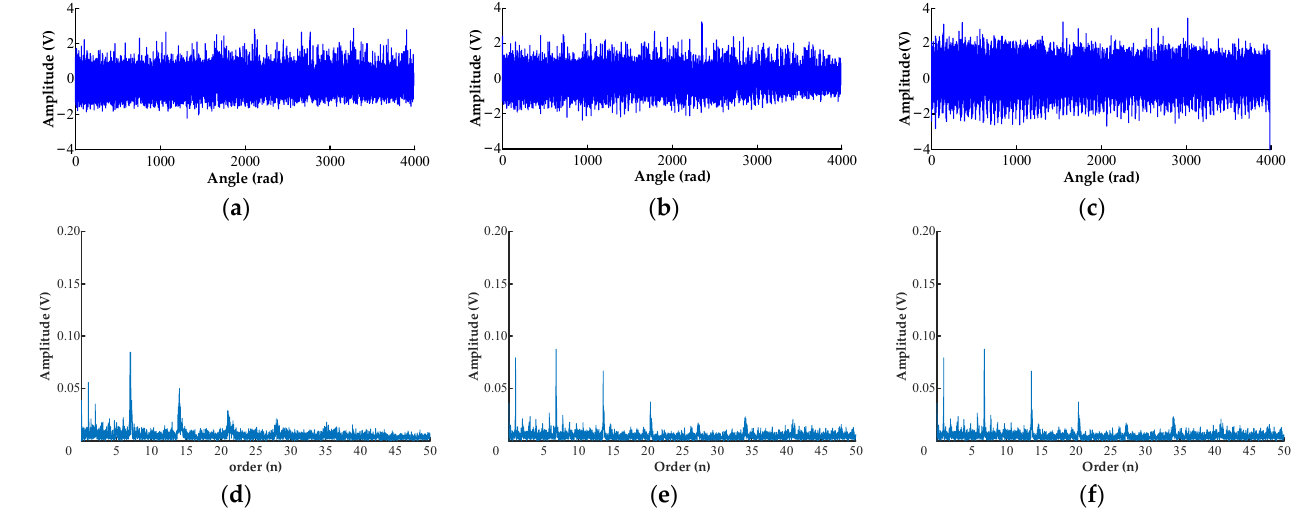
Figure 11. Angular domain vibration signal and order spectrogram under different wear states. ( a ) Angular vibration signal in zero wear state; ( b ) Angular vibration signal in mild wear state; ( c ) Angular vibration signal in moderate wear state; ( d ) Order spectrogram in zero state; ( e ) Order spectrogram in mild state; ( f ) Order spectrogram in moderate state.